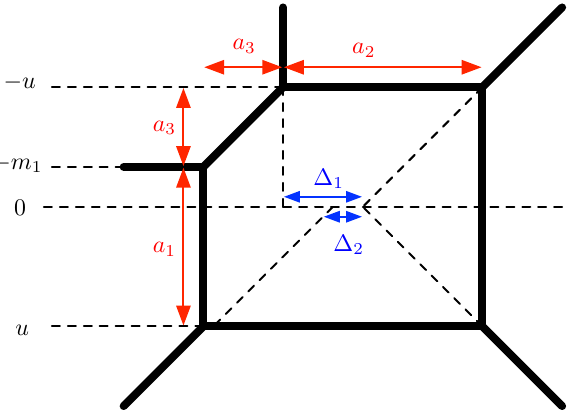
Figure 20. A parameterization of a 5-brane web diagram of the E 2